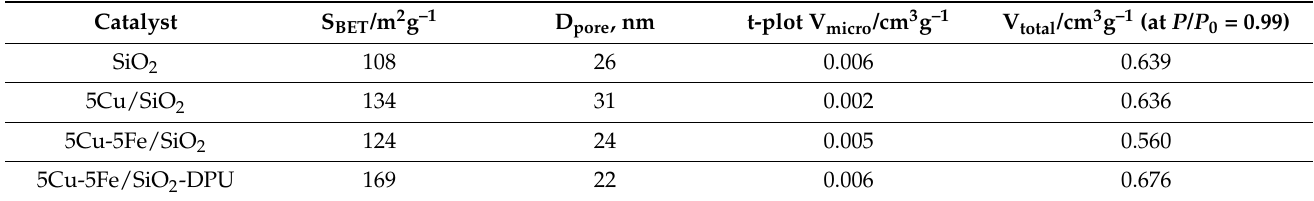
Table 2. The results of nitrogen adsorption–desorption